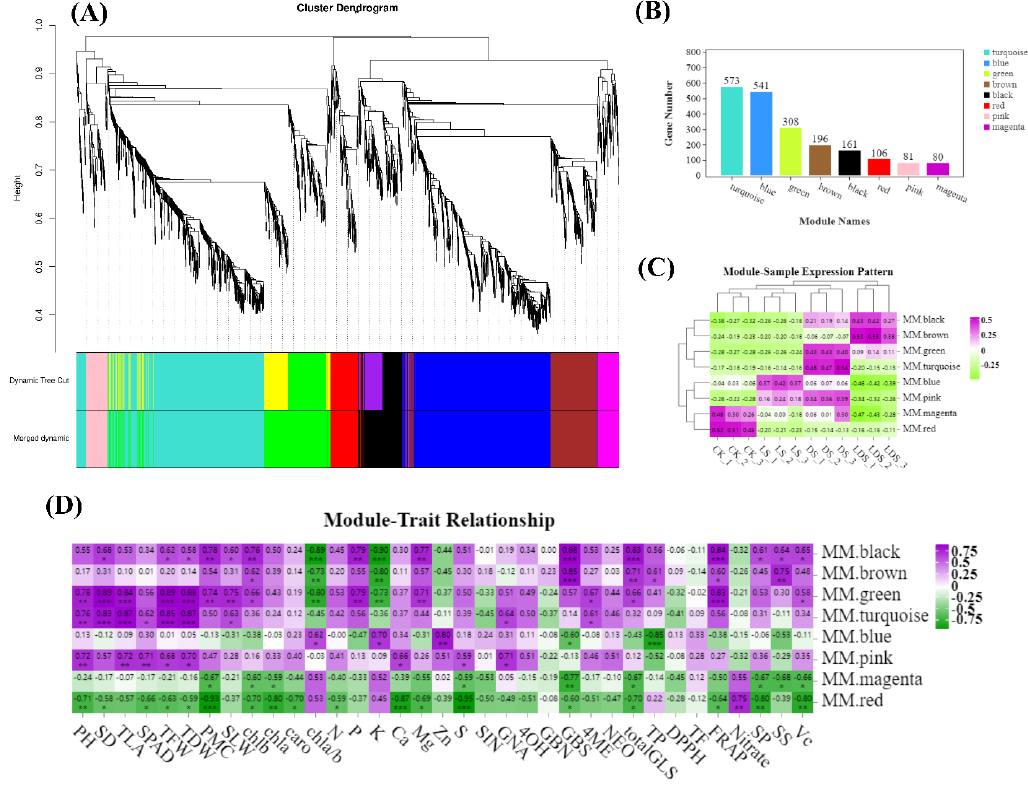
Figure 6. WGCNA of 2047 DEGs. ( A ) Cluster dendrogram indicating 8 modules of co-expressed genes by WGCNA. ( B ) Gene numbers of different modules. ( C ) Module-Sample expression patterns. ( D ) Module-trait correlations. p values were shown as: * p < 0.05, ** p < 0.01, *** p < 0.001. The full name of the traits has been described in Figure 2. The color scale shows correlations from positive (purple) to negative (green). “LS” = Light-UVA Supplementation, “DS” = Dark-UVA Supplementation, “LDS” = Light/Dark-UVA Supplementation.